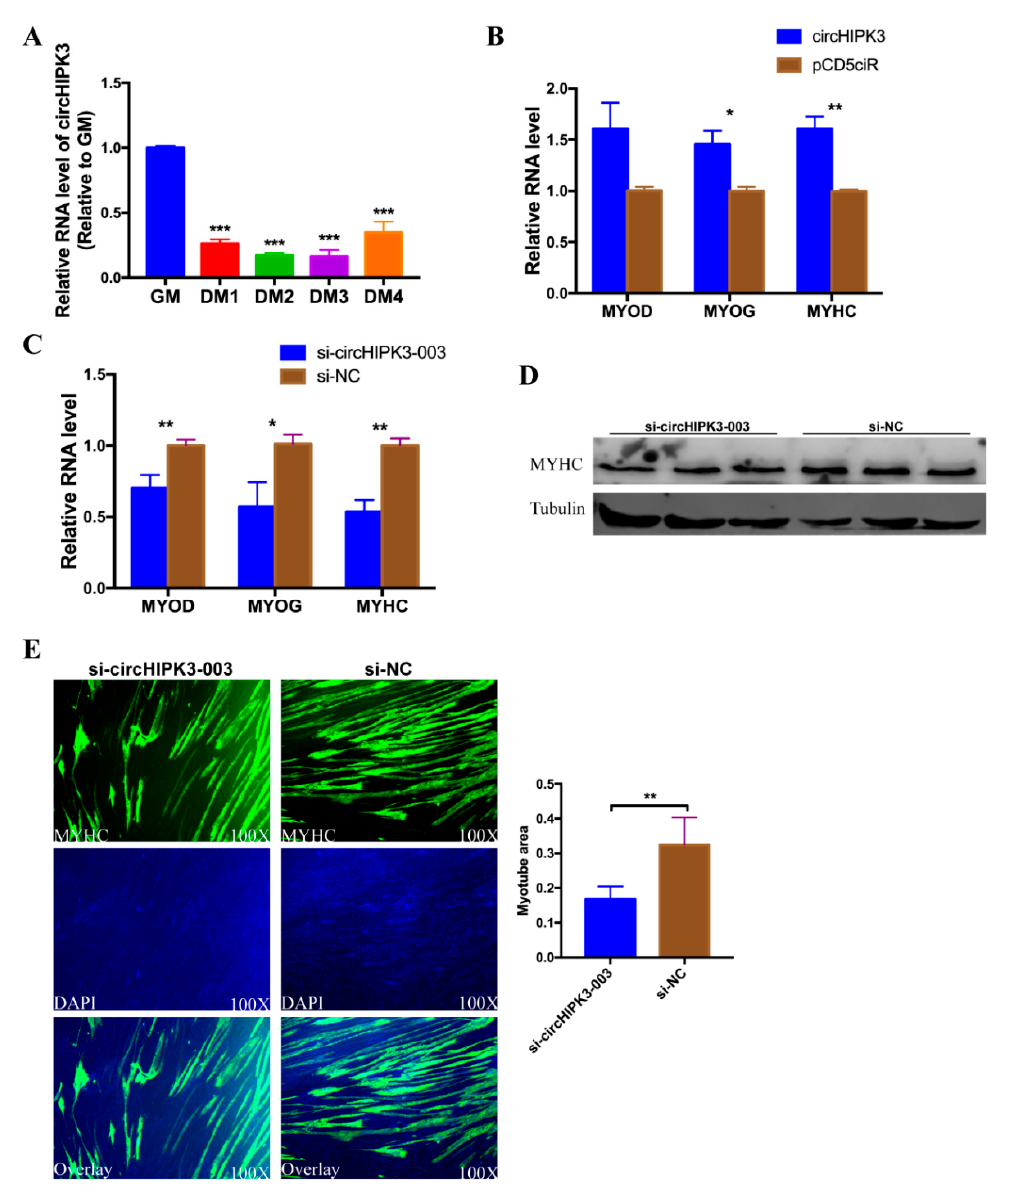
Figure 7. CircHIPK3 promotes the differentiation of CPMs. ( A ) The expression profile of circHIPK3 in the process of CPMs induced differentiation. ( B ) The expression level of MYOD , MYOG and MYHC in CPMs after over-expression of circHIPK3. ( C ) The expression of MYOD , MYOG and MYHC in CPMs after knock-down of circHIPK3. ( D ) The protein level of MYHC in CPMs after knock-down of circHIPK3. ( E ) Immunofluorescence analysis of MYHC-staining cells after knock-down of circHIPK3 in CPMs, * p < 0.05; ** p < 0.01; *** p <